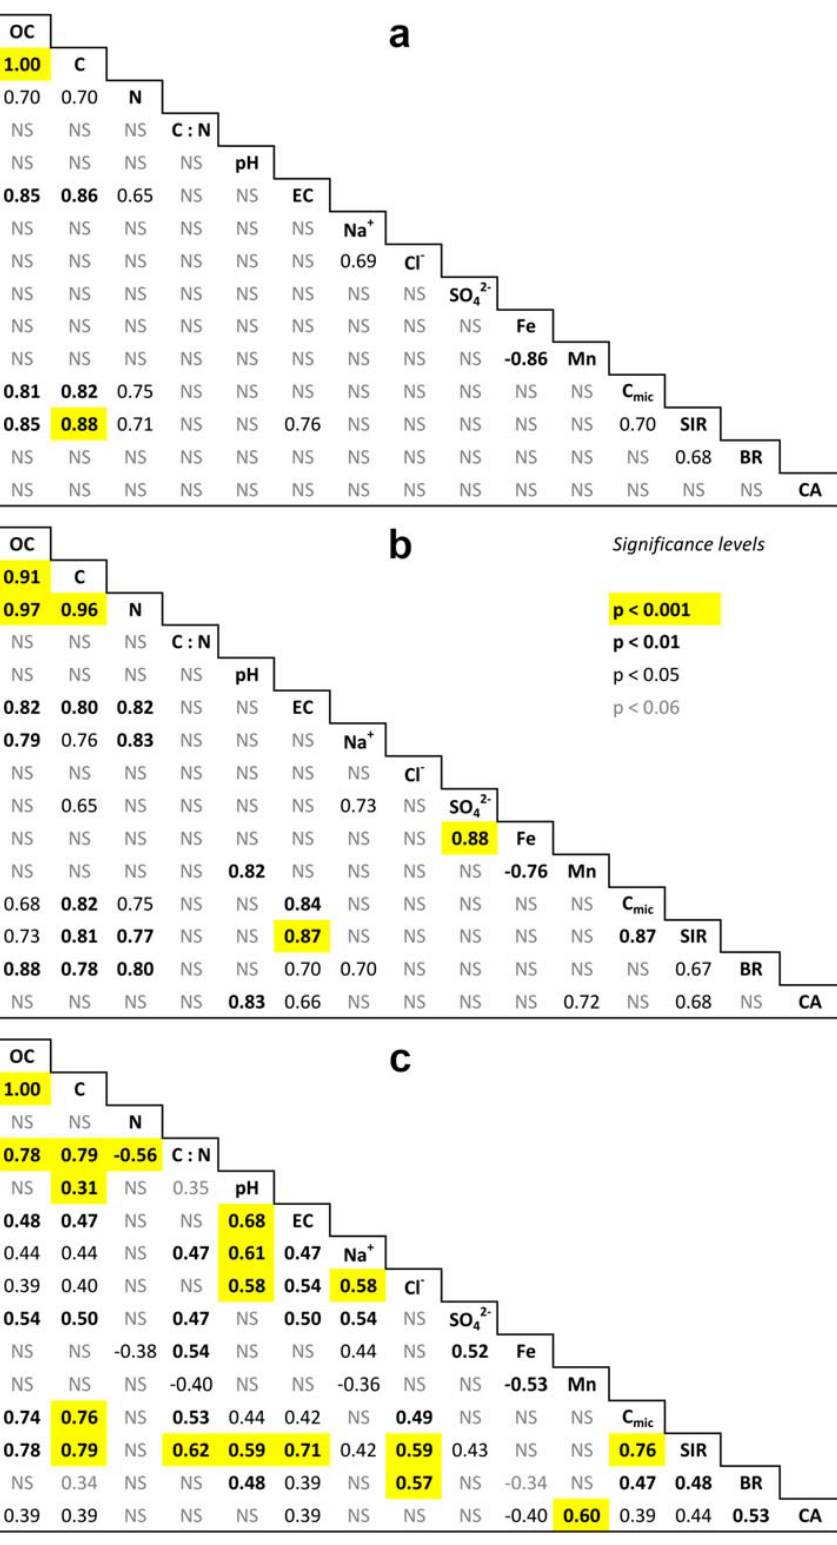
Figure A3. Correlation matrices (Pearson correlation coefficients) of the Box-Cox transformed soil data at ( a ) Bedrich, ( b ) Placek A, and ( c ) Placek B sites in 2020; OC = organic carbon; C = total carbon; N = total nitrogen; EC = electrical conductivity; C mic = microbial-biomass carbon; SIR = substrate-induced respiration; BR = basal respiration; CA = catalase activity; NS = no significant correlation.